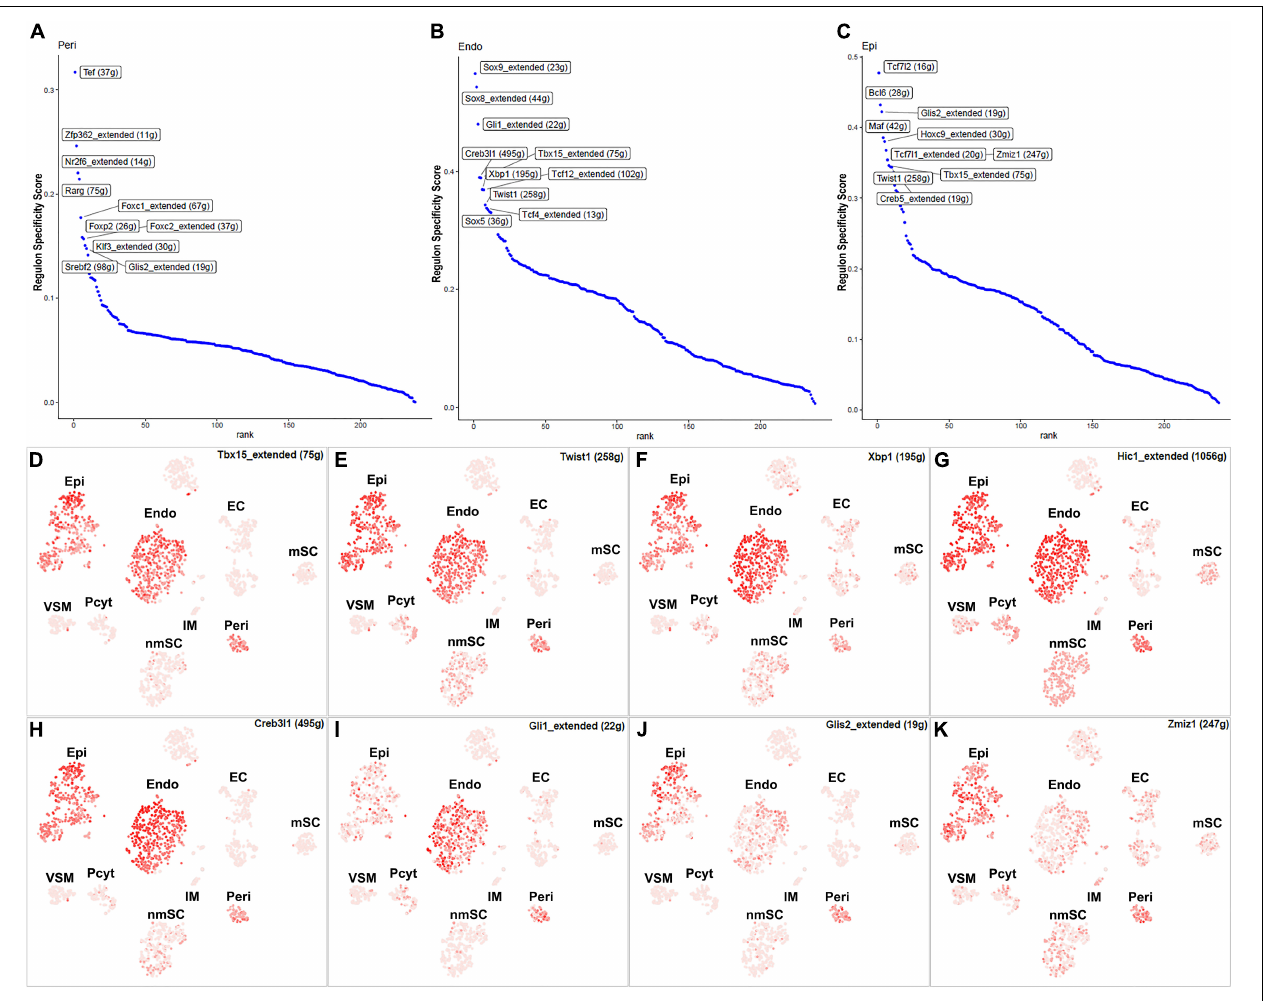
FIGURE 6 | TFs showing regulon activities in fibroblasts. (A) Regulon-specificity score in perineurial fibroblasts with top 10 specific TFs labeled. (B) Regulon-specificity score in endoneurial fibroblasts with top 10 specific TFs labeled. (C) Regulon specificity score in epineurial fibroblasts with top 10 specific TFs labeled. (D–K) tSNE showing regulon activity for Tbx15, Twist1, Xbp1, Hic1, Creb3l1, Gli1, Glis2, and Zmiz1 in